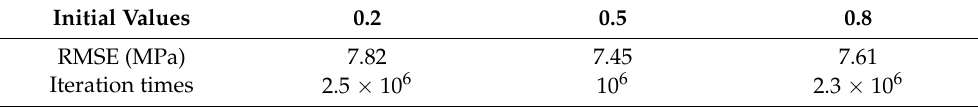
Table 2. RMSE and iterations of the inverse algorithm under different initial values.